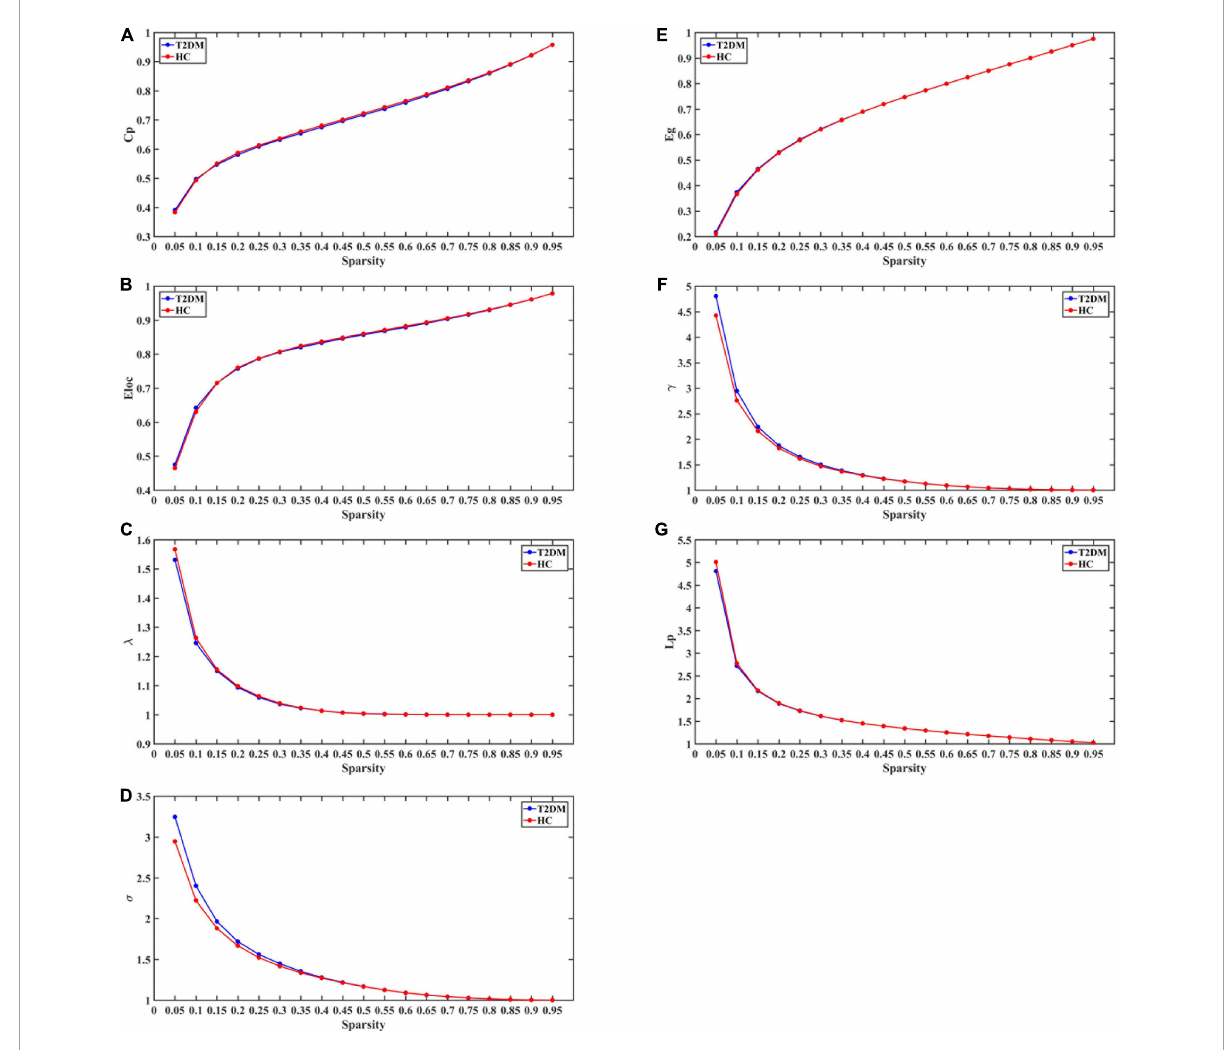
FIGURE2 The global topological metrics of the whole-brain functional network of the T2DM and HC. Graph (A–G) show the small-word properties and network efficiency under different sparsity (0.05 < S < 0.95). Cp, clustering coefficient; Lp, characteristic path length; γ , normalized clustering coefficient; λ , normalized shortest path length; σ ,small-world characteristics; Eg, global efficiency; Eloc, local